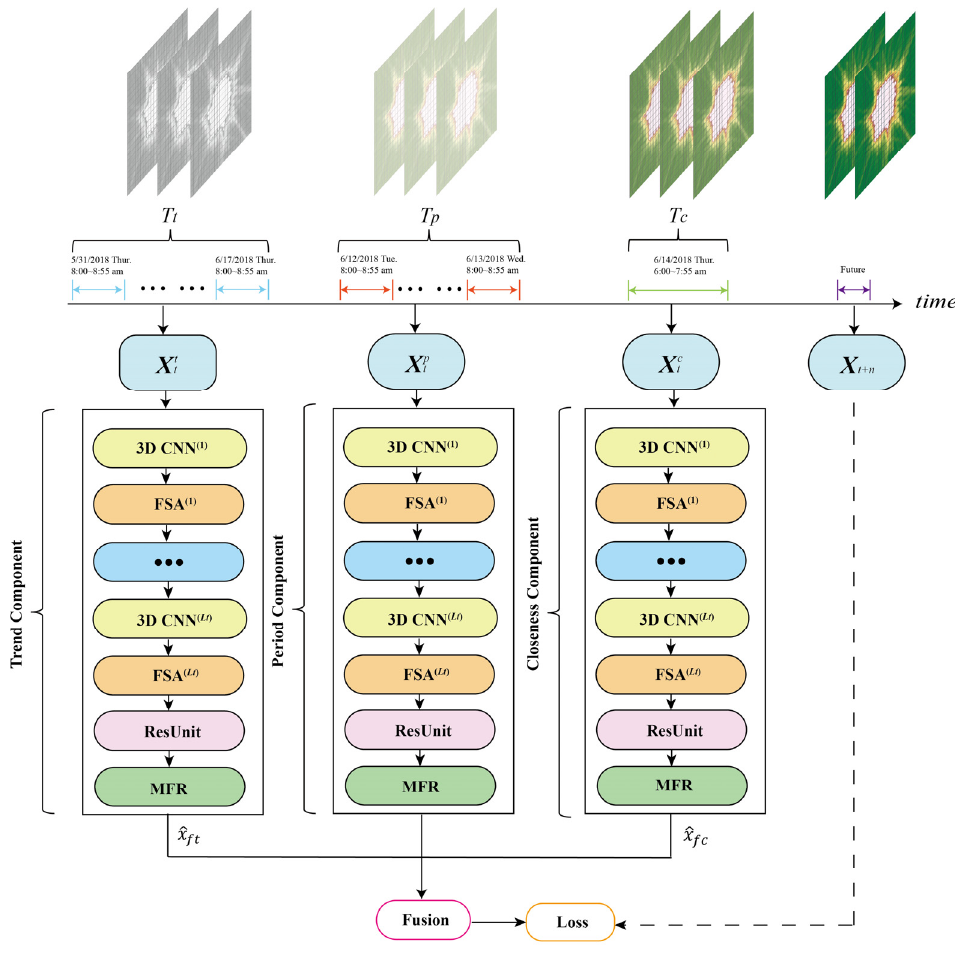
Figure 3. The framework of FASTNN .